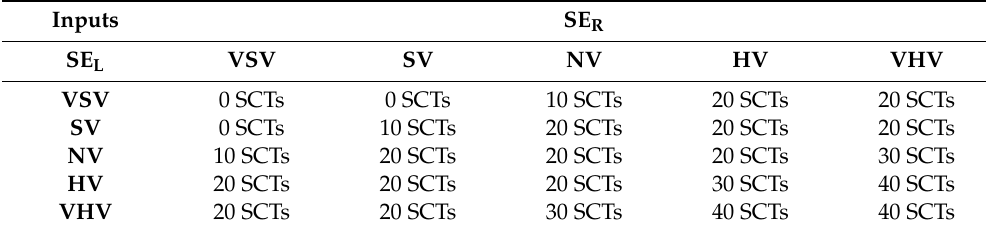
Table 3. Classification results (confusion matrix).